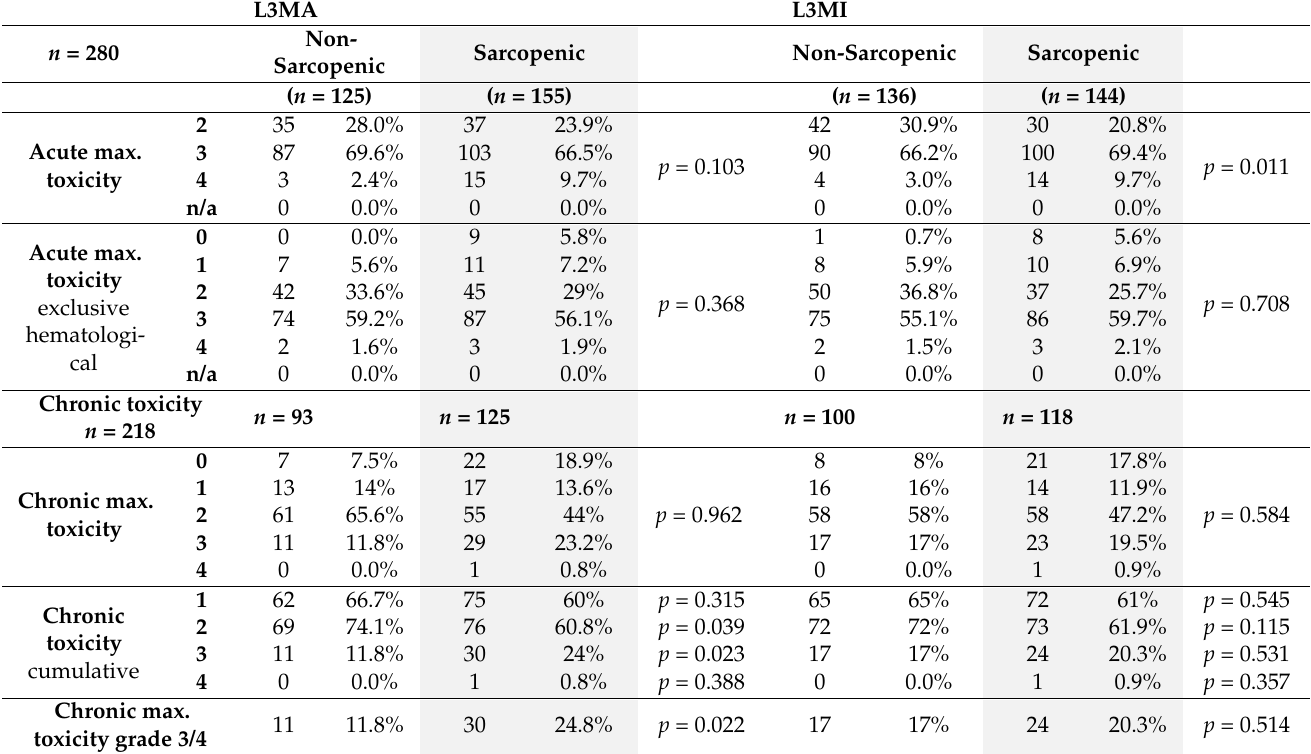
Table 4. Comparison of treatment-related toxicities following the CTCAE v.5 for pretherapeutic sarcopenic and non-sarcopenic elderly HNSCC patients undergoing curative (chemo)radiotherapy. p values given for group comparison with Mann–Whitney U tests and Fisher’s exact tests. L3MA, calculated cross-sectional skeletal muscle area at the third lumbar vertebra; L3MI, calculated skeletal muscle index at the third lumbar vertebra; n , number of patients.